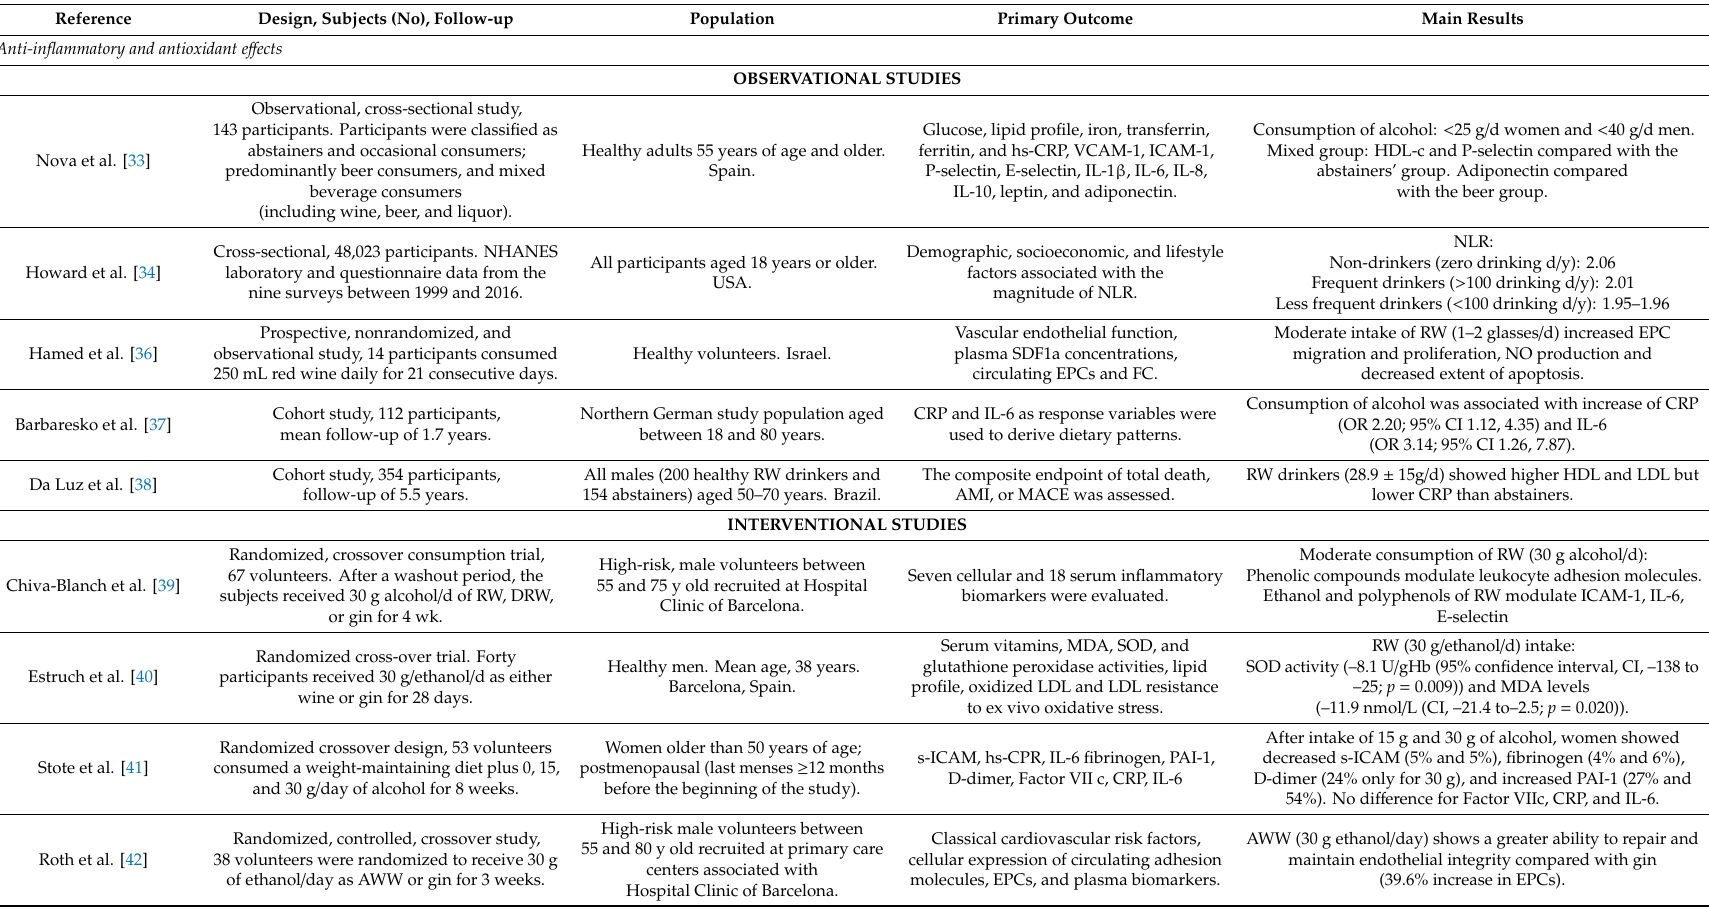
Table 1. Characteristics of studies evaluating anti-inflammatory, antioxidant, and antithrombotic e ff ects of